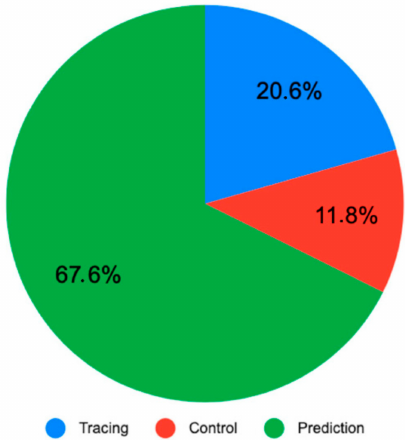
Figure 15. Application Domains.